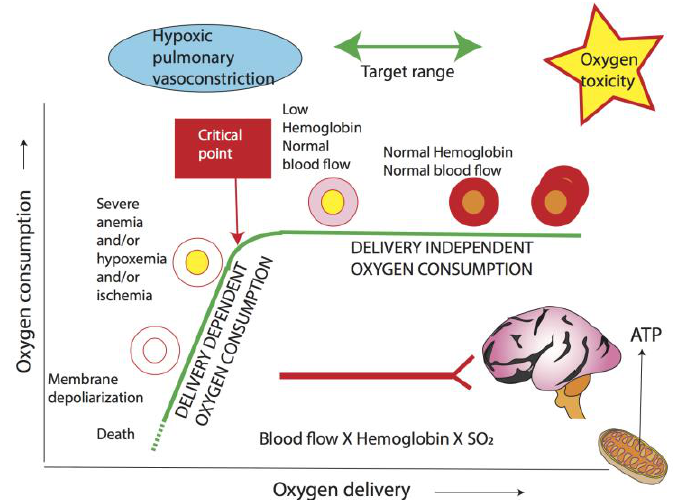
Figure 5. Relationship between oxygen delivery and consumption. O 2 delivery is a product of blood flow and arterial O 2 content. When O 2 delivery decreases below a critical point, O 2 consumption is compromised leading to anaerobic metabolism and lactic acidosis. The driving force for O 2 into mitochondria is PO 2 . Increased mitochondrial PO 2 can lead to reactive oxygen species formation, while hypoxia can exacerbate pulmonary vasoconstriction. The optimal target range encompasses oxygenation that guarantees an oxygen delivery higher than the critical point so that oxygen consumption is not dependent on delivery, while also avoiding oxygen toxicity. Hb: hemoglobin; SaO 2 : arterial oxyhemoglobin saturation (Copyright Satyan Lakshminrusimha).